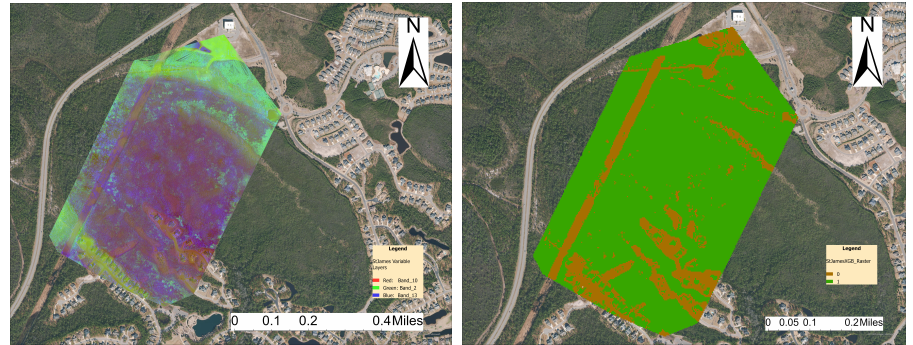
Figure 5. Visual representation of the spectral bands of the StJames site ( left ) and the XGBM classifi- cation model for the St. James site ( right ).